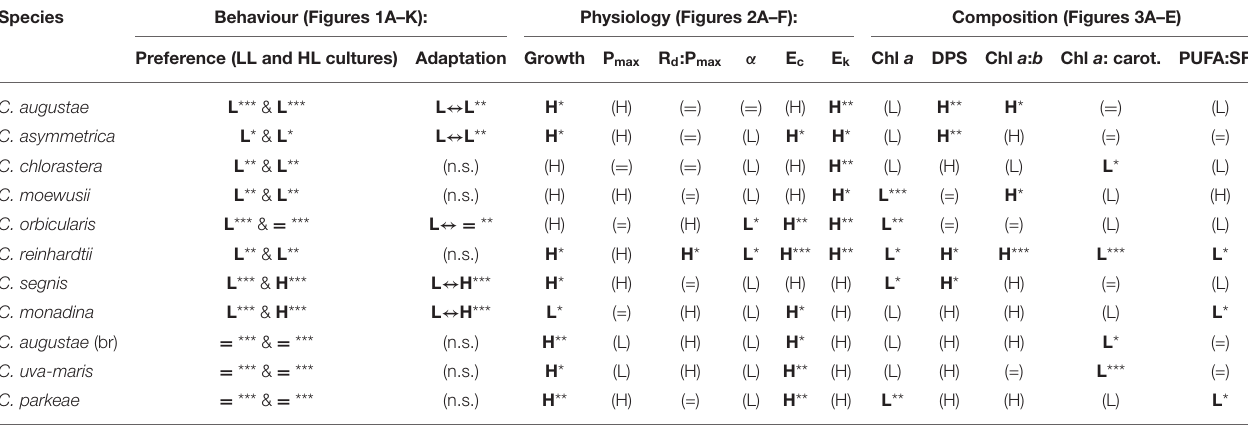
TABLE 2 | Summary of predominant trends in the behavioural, physiological, and compositional data across the 11 species of Chlamydomonas .